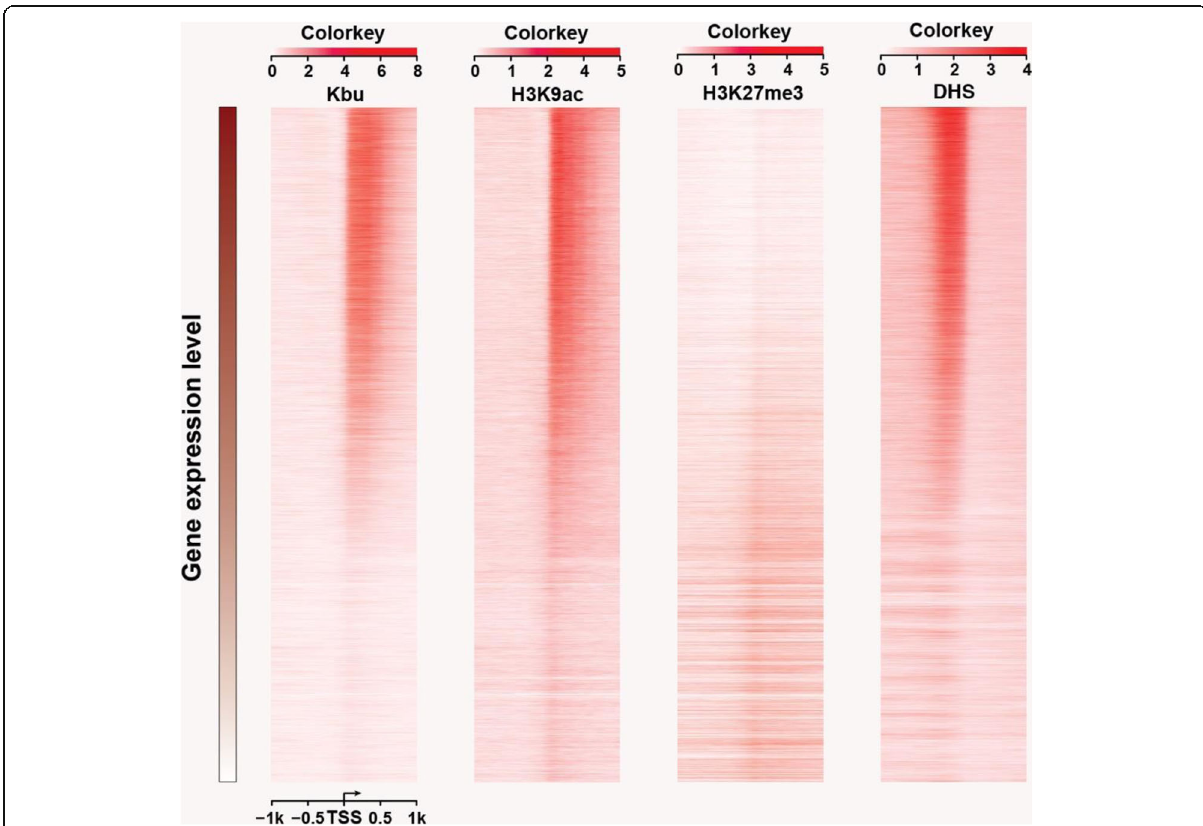
Fig. 5 Heatmaps of histone Kbu, H3K9ac, H3K27me3, and DHS in gene regions and intergenic regions. The DNA regions 1 kb upstream and 1 kb downstream of the transcription start sites were analyzed. Density was calculated by the number of reads per kilobase region per million mapped